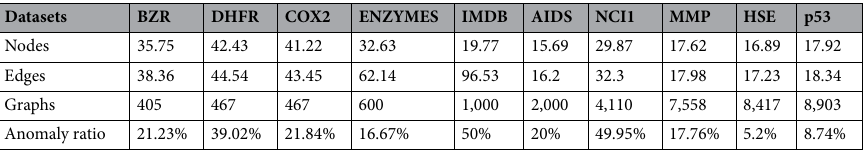
Table 1. Statistics and properties of graph anomaly datasets.